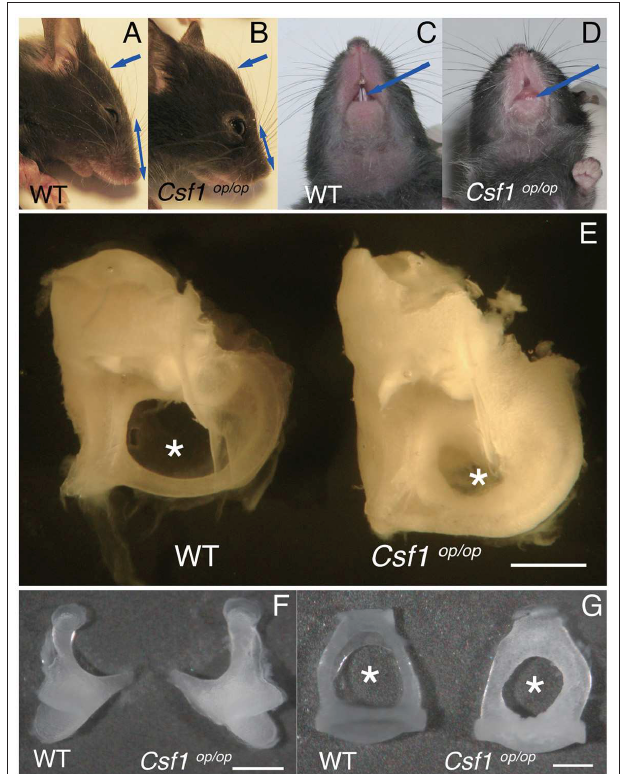
FIGURE 1 | Macroscopic phenotypes of the skull and ear in Csf1 op / op mice. (A–D) Csf1 op / op mice are clearly recognized by a distinctly domed skull and short snout ( A,B , arrows and double headed arrows) and failure of eruption of the incisors ( C,D , arrows). (E) Image of dissected cochleae from a representative set of wild type ( WT ) and Csf1 op / op mice. The subarcuate fossa surrounded by the superior semicircular canal is remarkably small due to excessive bone formation of the inner ear in Csf1 op / op mice (asterisks). Hypertrophy of the incus (F) and stapes (G) taken from Csf1 op / op mice is shown in comparison to WT mice. The obturator foramen between the anterior and posterior crus is also remarkably small (asterisks). Bars: 1mm for (E) , 500 µ m for (F) , and 200 µ m for (G)